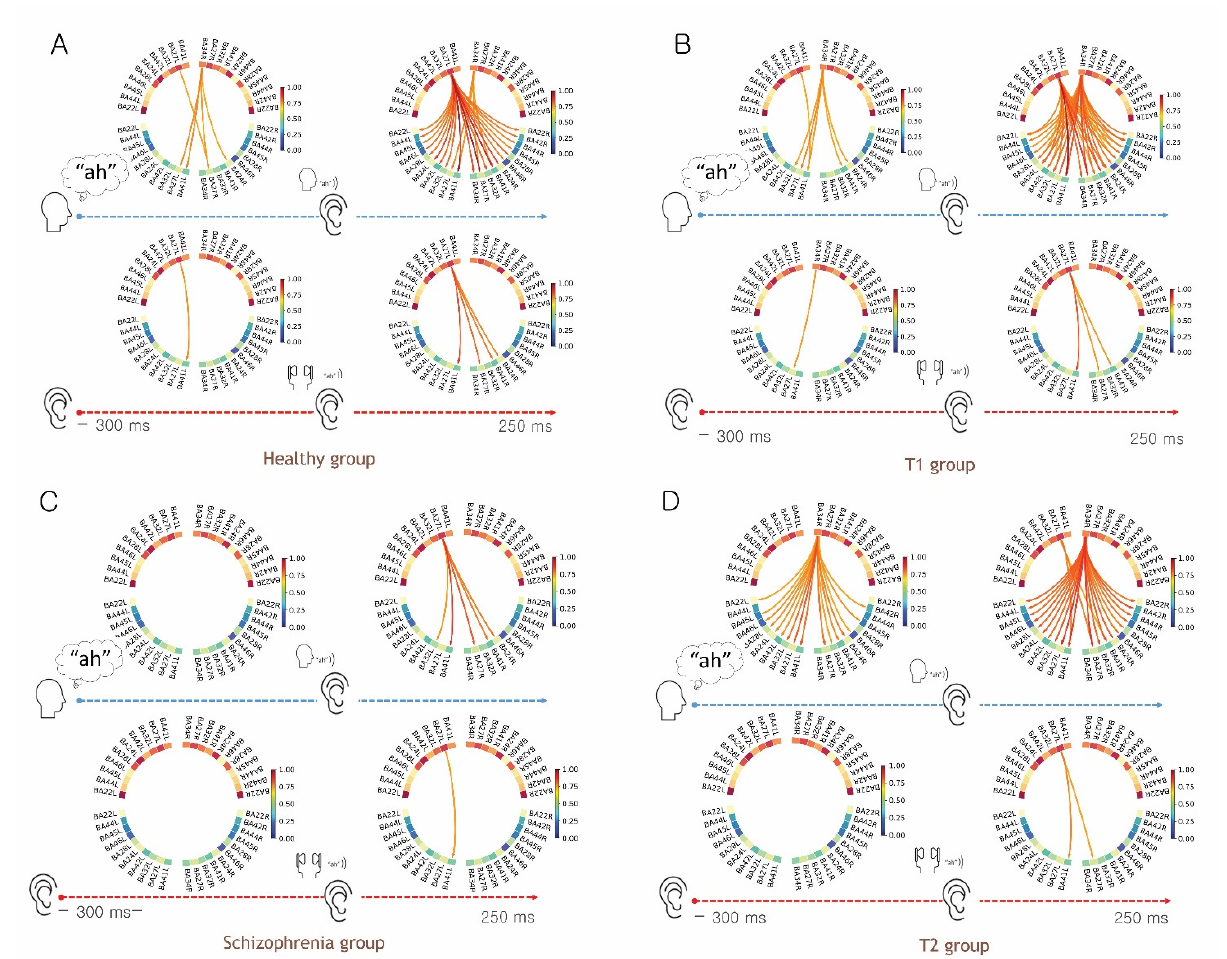
Figure 4. Representation of dynamic change in causal connectivity for grand-averaged evoked alpha activity. ( A ) Healthy control group. ( B ) T1 group (tinnitus without subjective hearing loss). ( C ) Schizophrenia group. ( D ) T2 group (tinnitus with subjective hearing loss). Note that reafferent auditory stimulation led to a dominance shift during the Talk paradigm in healthy control and T1 groups. However, the dominance shift was not observed in the T2 group. Outflows were not observed in the schizophrenia group. Color-scaled directional arrows link two causally connected regions of interest (ROIs) across 21 ROIs (BA24L/R, BA22L/R, BA27L/R, BA28L/R, BA32L/R, BA34R, BA41L/R, BA42L/R, BA44 L/R, BA45L/R, and BA46L/R).